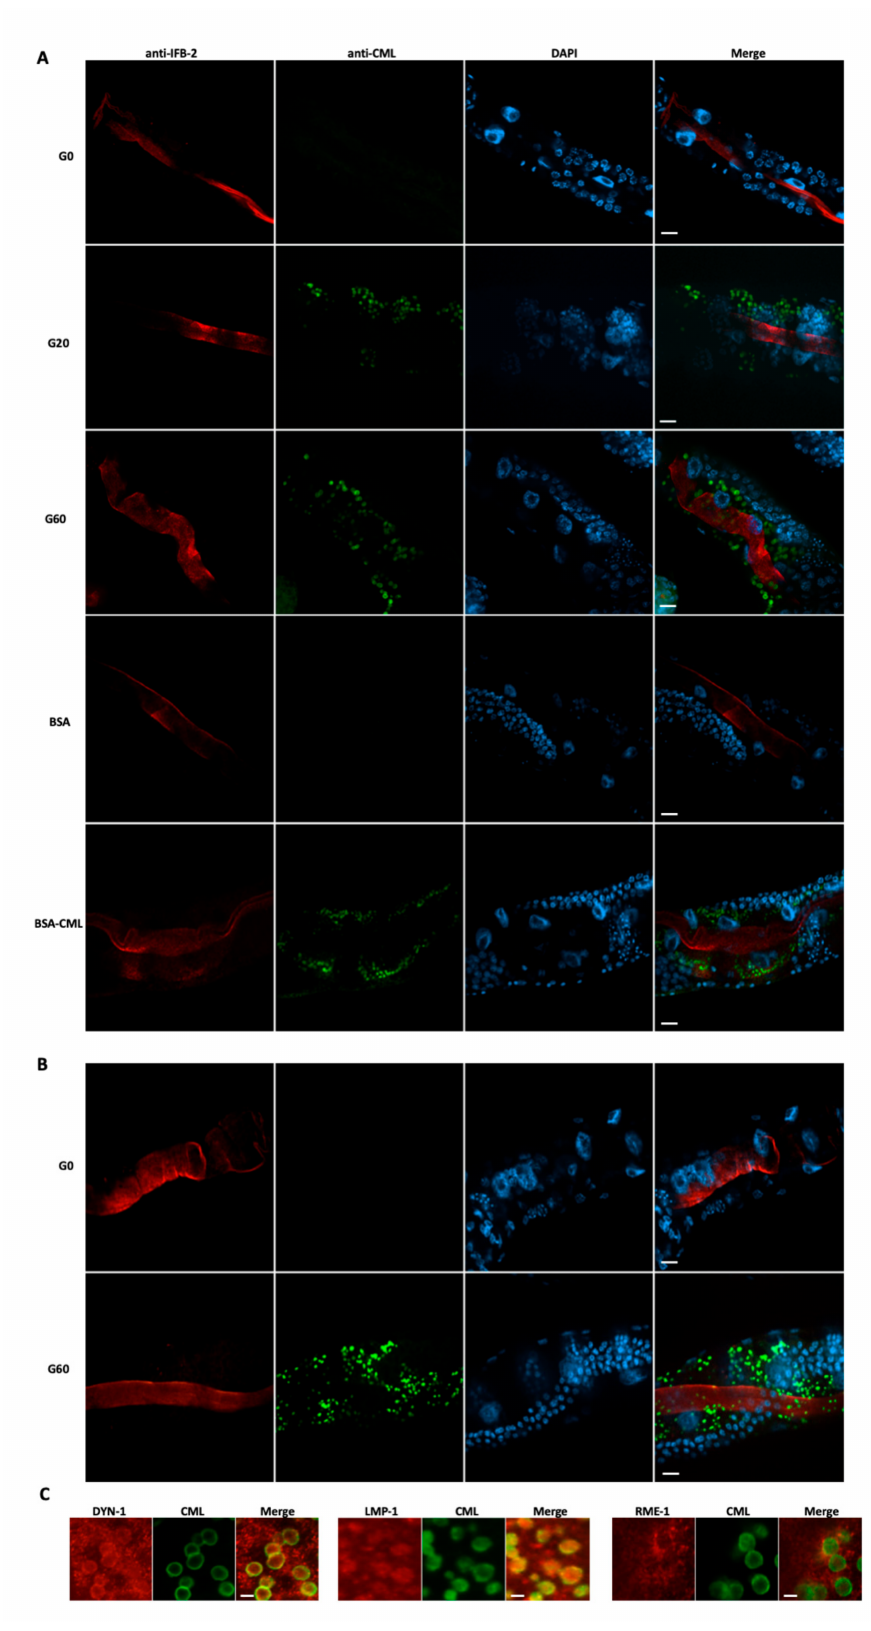
Figure 4. Mapping of N ε -carboxymethyllysine (CML) epitopes in C. elegans intestine. ( A ) Immuno- histochemical staining was performed on worms fed for 4 days with bacteria, which were